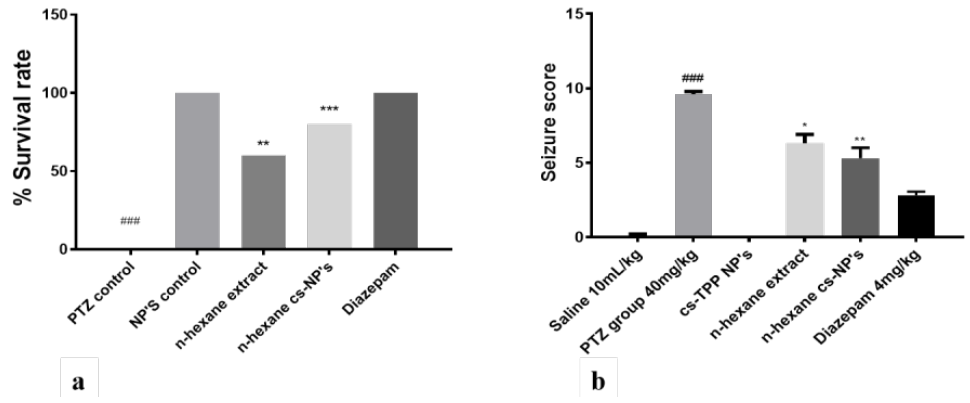
Figure 7. Illustrates ( a ) percent survival rate of all treated groups; symbols ** and *** show the significant difference from PTZ group at p < 0.01 and p < 0.001; symbol ### shows significant difference from NPs control at p < 0.00. ( b ) Seizure score of all treated groups; symbols *, ** and ### indicate significant differences at p < 0.05, p < 0.01 (from PTZ) and p < 0.001 (from normal saline), re- spectively.